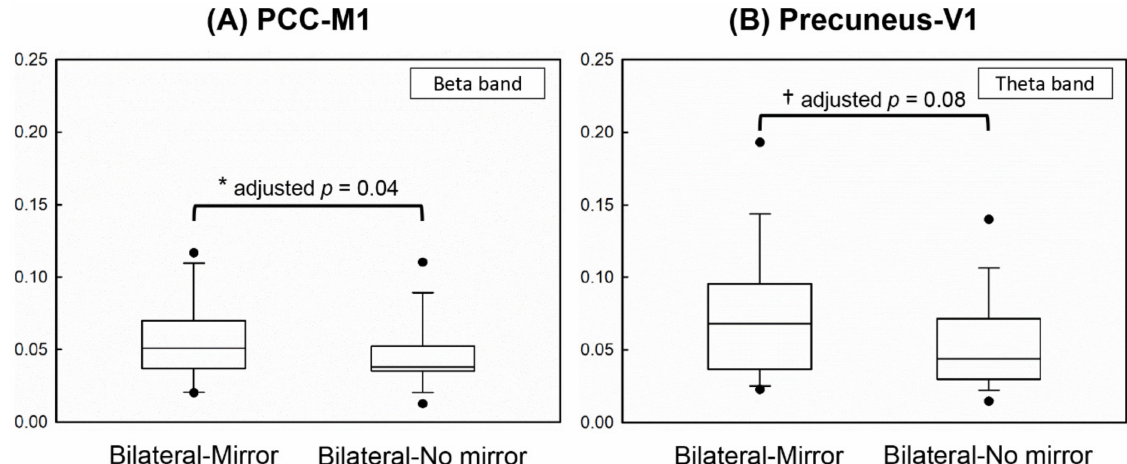
Figure 3. Demonstration of the statistical results using the box plot. ( A ) Significantly higher cortical coherence between PCC and M1 in the beta frequency was found in the Bilateral-Mirror condition than in the Bilateral-No mirror condition. ( B ) The coherence strength between the precuneus and V1 in the theta frequency revealed a greater trend in the Bilateral-Mirror condition than in the Bilateral-No mirror condition. * represents a significant difference after Benjamini–Hochberg method; † represents an approached significant difference.